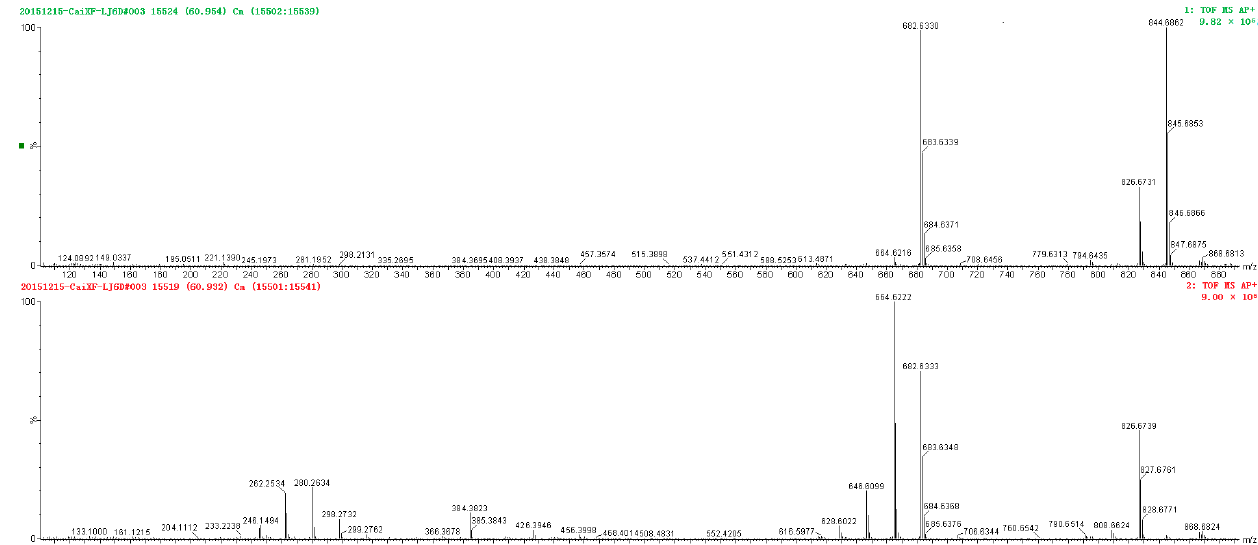
Figure 2. MS and MS/MS spectra of compound 13 .